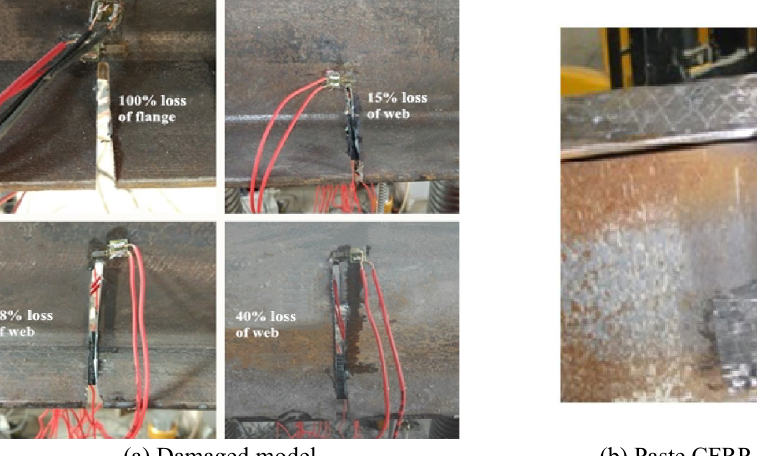
Figure 1. The preparation of specimens.